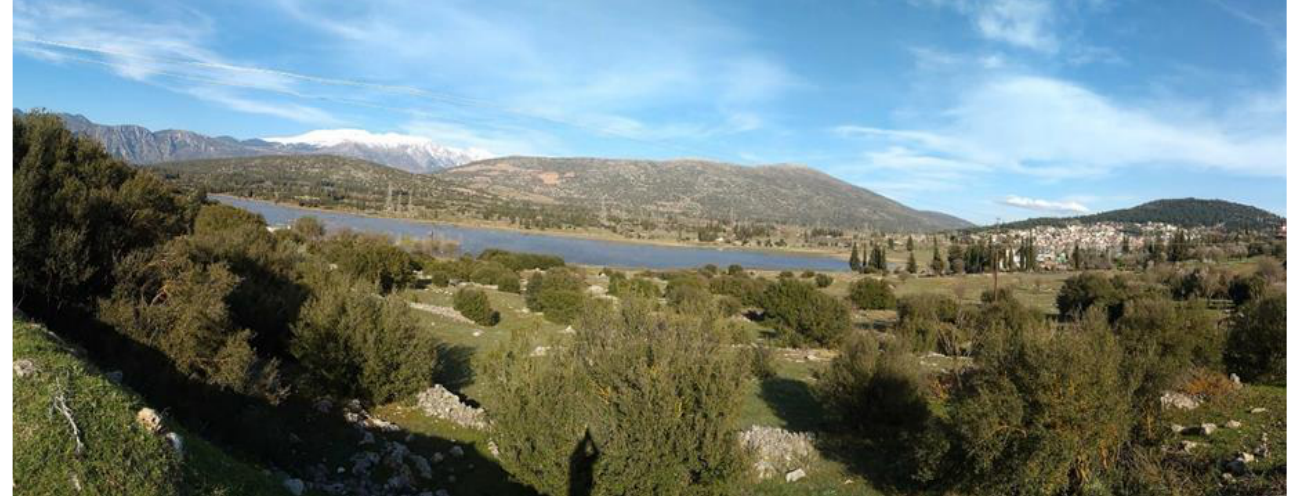
Figure 2. A panoramic photo of formation of a seasonal lake in the vicinity of Desfina (on the right), and snowy Mount Parnassus can be seen in the background (© IL).